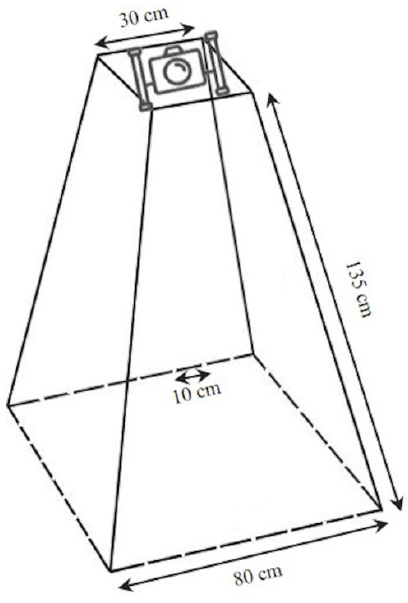
Figure 3. Technical features of the Megabenthos Underwater